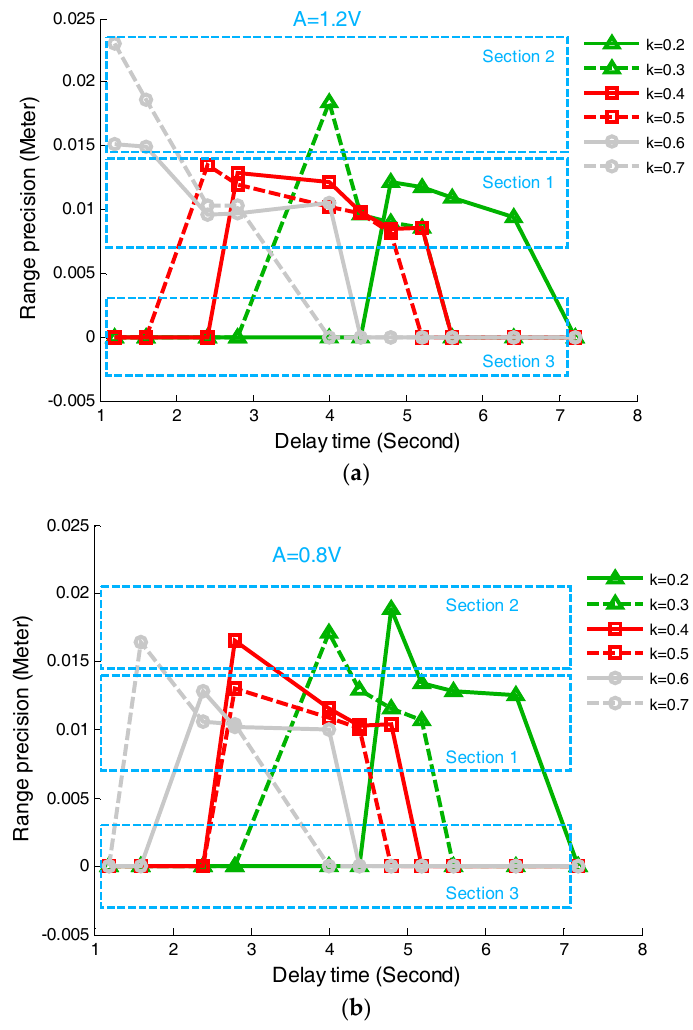
Figure 13. Variation of DEstd with the increase of t d for different pulse amplitudes. ( a ) Relationship between DEstd and t d when A = 1.2; ( b ) Relationship between DEstd and t d when A = 0.8. DEstd is the delay time-based experimental StD .